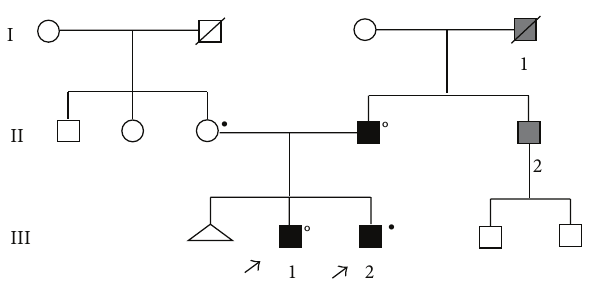
Figure 1: Pedigree of the first family with the presence of hyper- ferritinemia and cataract, because of the C33T mutation of the L- ferritin IRE region and H63D mutation of HFE gene. Black squares indicate affected individuals (II: 1; III: 1; III: 2) with early onset of cataract, hyperferritinemia, and L-ferritin IRE mutation. Grey squares indicate individuals (I: 1; II: 2) with early onset of cataract but unavailable for ferritin study and mutational analysis; ∘ members heterozygous for HFE-H63D genotype; ∙ members homozygous for HFE-H63D genotype.